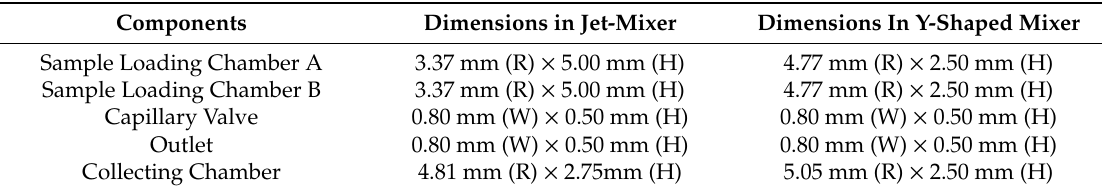
Table 1. The dimensions of the common components for the jet mixer and Y-shaped mixer (radius—R, height—H,